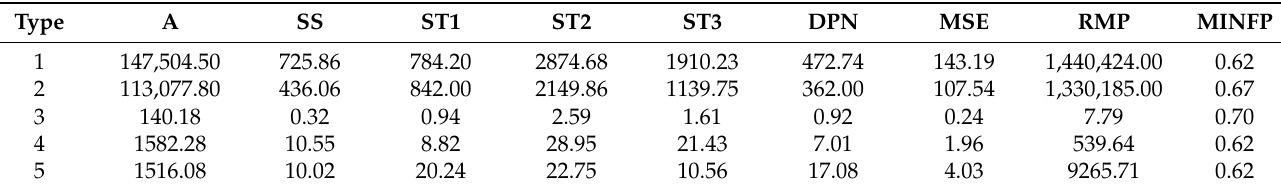
Table 5. Electricity characteristics in November.